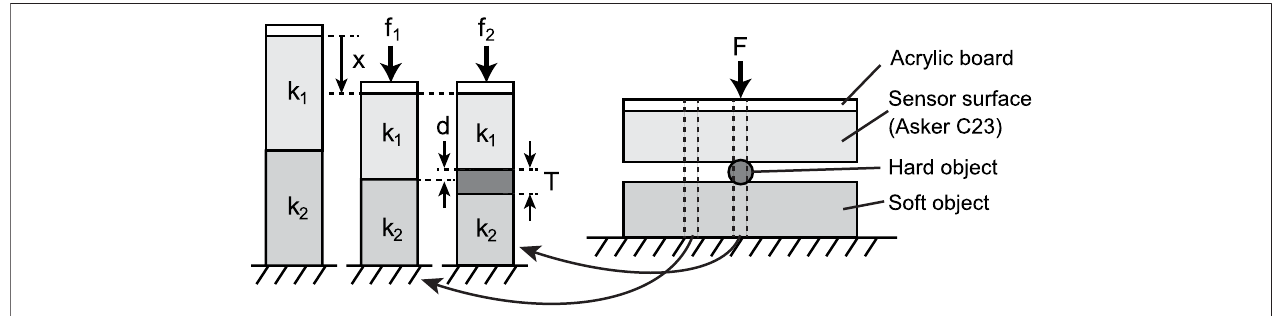
FIGURE11| Simplespringmodelofforeignbodiesdetectionmechanismwiththetactileimagesensor.Rightimageshowsthesamesituationas Figure6A ,where the sensor skin ispushing thehard foreign object located on thesoft food. Considering asmall compartmentextracted from twodifferentpart ofthe right fi gure, thepart includinghardobjectandthepartwithouthardobject,toestimatethestaticcharacteristicsofthedeformationofsensorskinandsoftobjectinthesetwocompartments.